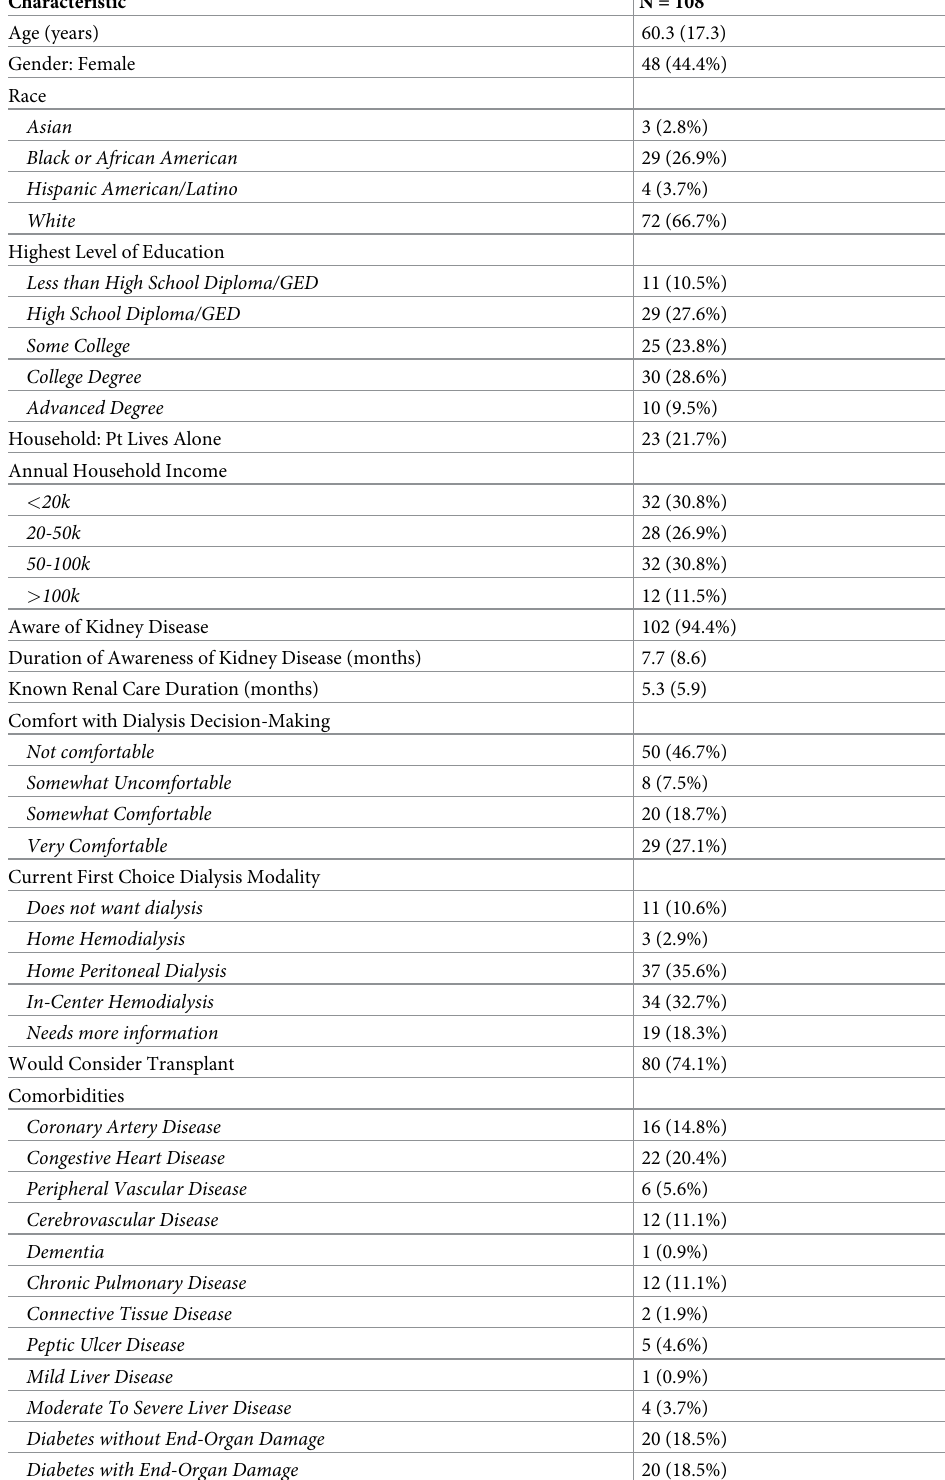
Table 4. Patient